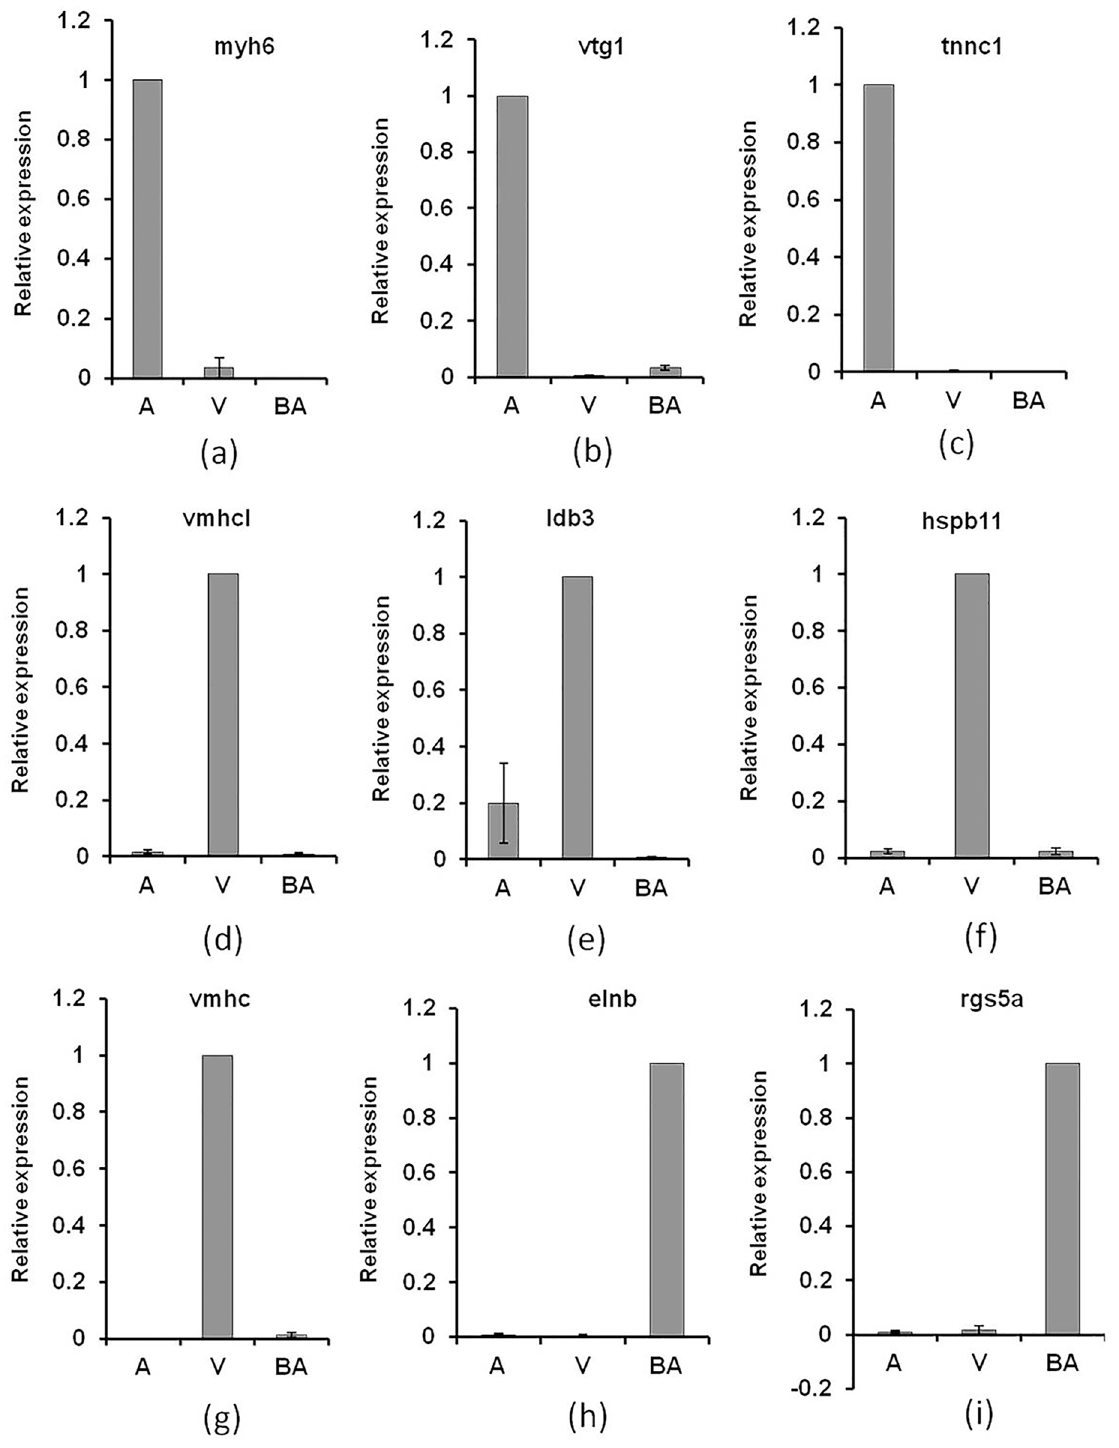
Fig 3. Quantitative Real time PCR based validation of chamber-restricted candidate genes. Atrium-restricted genes (a), (b) and (c). Ventricle-restricted genes (d), (e), (f) and (g). Bulbus arteriosus-restricted genes (h) and (i). See text for detailed information.